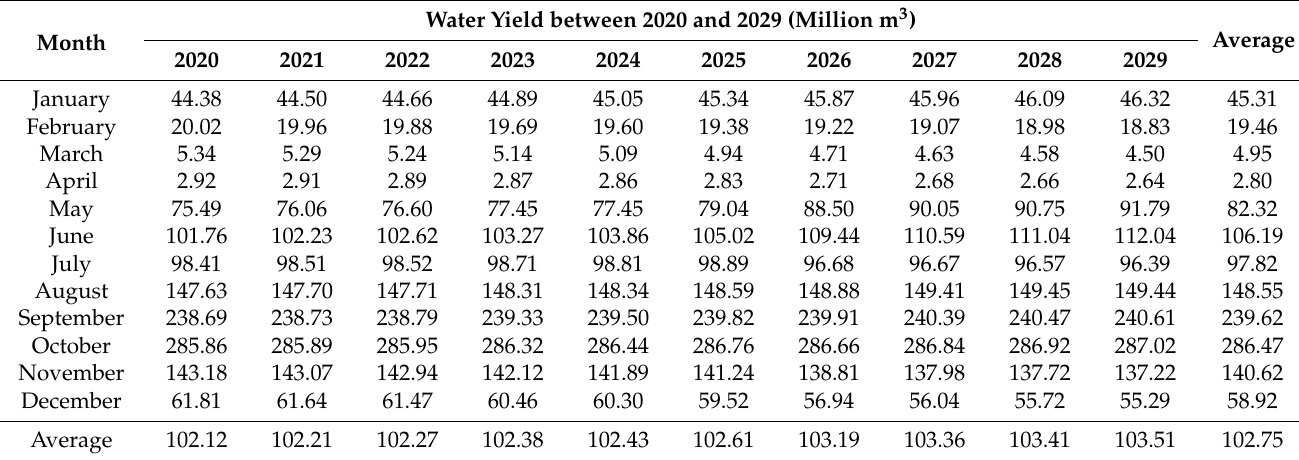
Table 19. Monthly water yield of Phuket Island between 2020 and 2029 under wet year